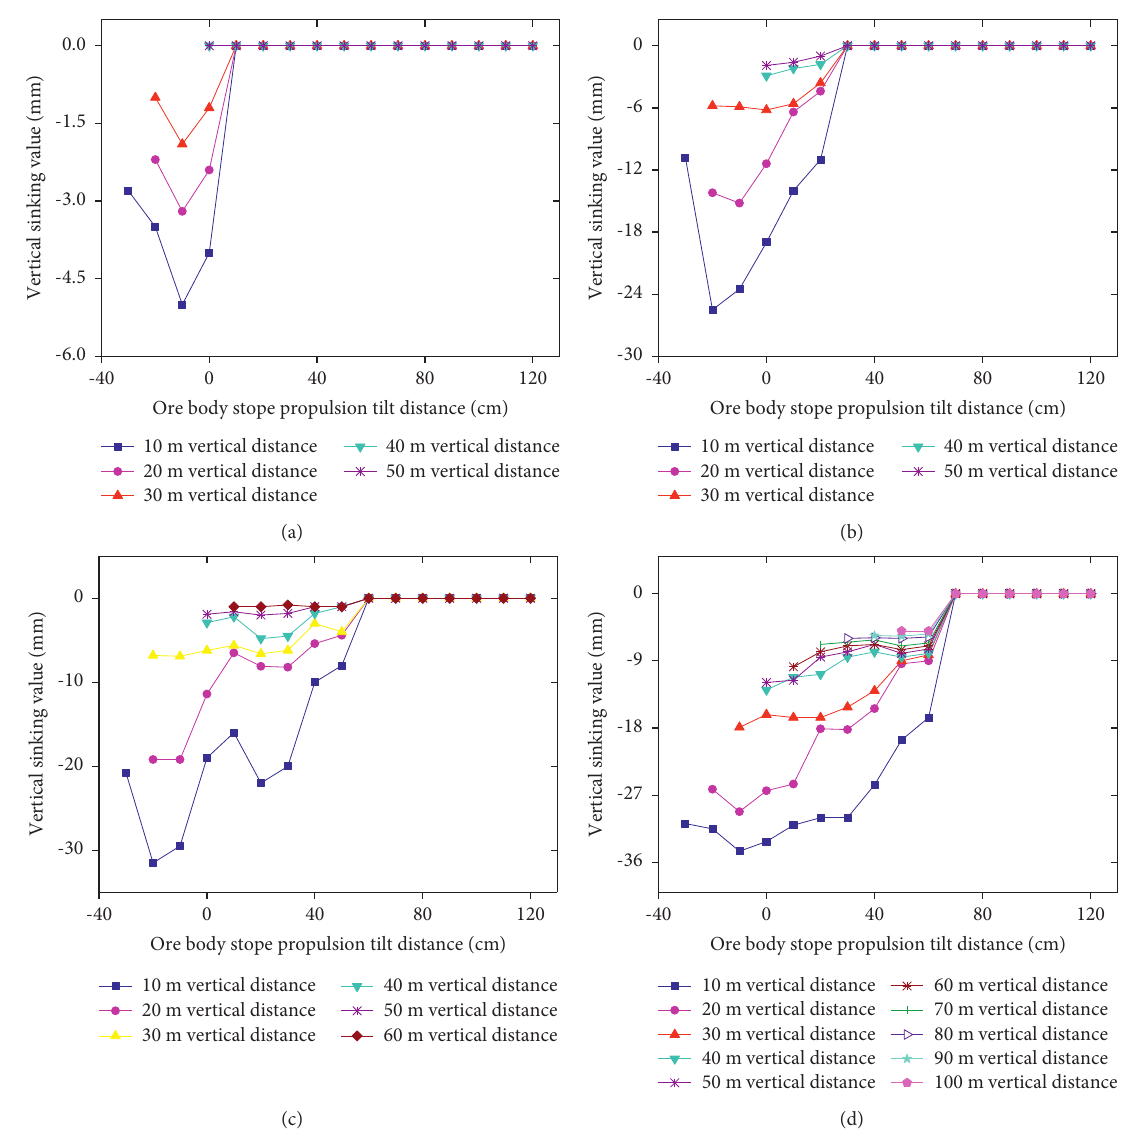
Figure 9: Surveying variation curve of vertical displacement follows each exploit progress (50 ° ). (a) Variation curve of vertical subsidence after 1-step excavation. (b) Variation curve of vertical subsidence after 5-step excavation. (c) Variation curve of vertical subsidence after 8- step excavation. (d) Variation curve of vertical subsidence after 10-step